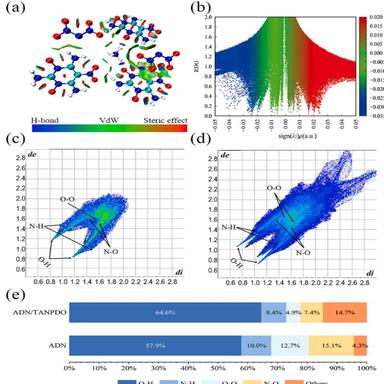
(a) The NCI calculation for ADN/ TANPDO supramolecular crystal. (b) Plots of the reduced density gradient (RDG in a.u.) against the sign of the second Hessian eigenvalue multiplied by the electron density (sign (λ2) ρ in a.u.) for ADN/TANPDO supramolecular crystal. (c) The 2D fingerprint calculation for ADN. (d) The 2D fingerprint calculation for ADN/ TANPDO supramolecular crystal. (e) Different percentages of atom contacts between ADN and ADN/TANPDO supramolecular crystal.